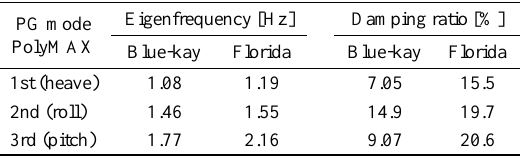
Semi-active suspension car: Comparison of modal parameters estimated in different proving ground